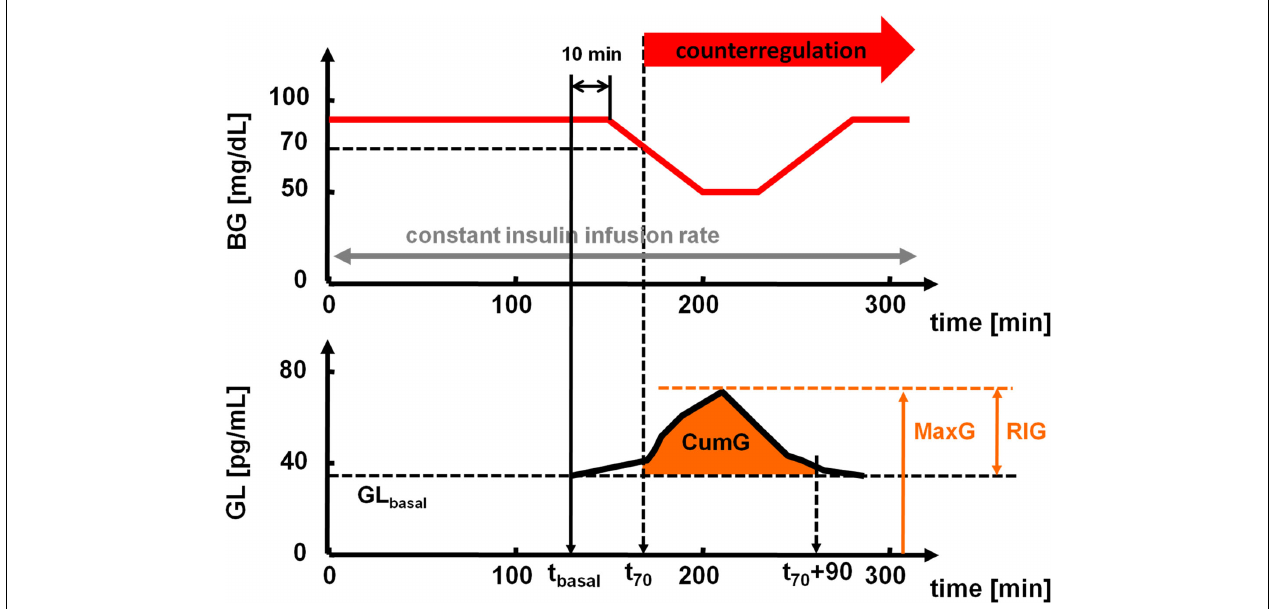
FIGURE 1 |Top: timeline of the hyperinsulinemic euglycemic–hypoglycemic clamp. Bottom: schematic presentation of the measures used to estimate the GCR.